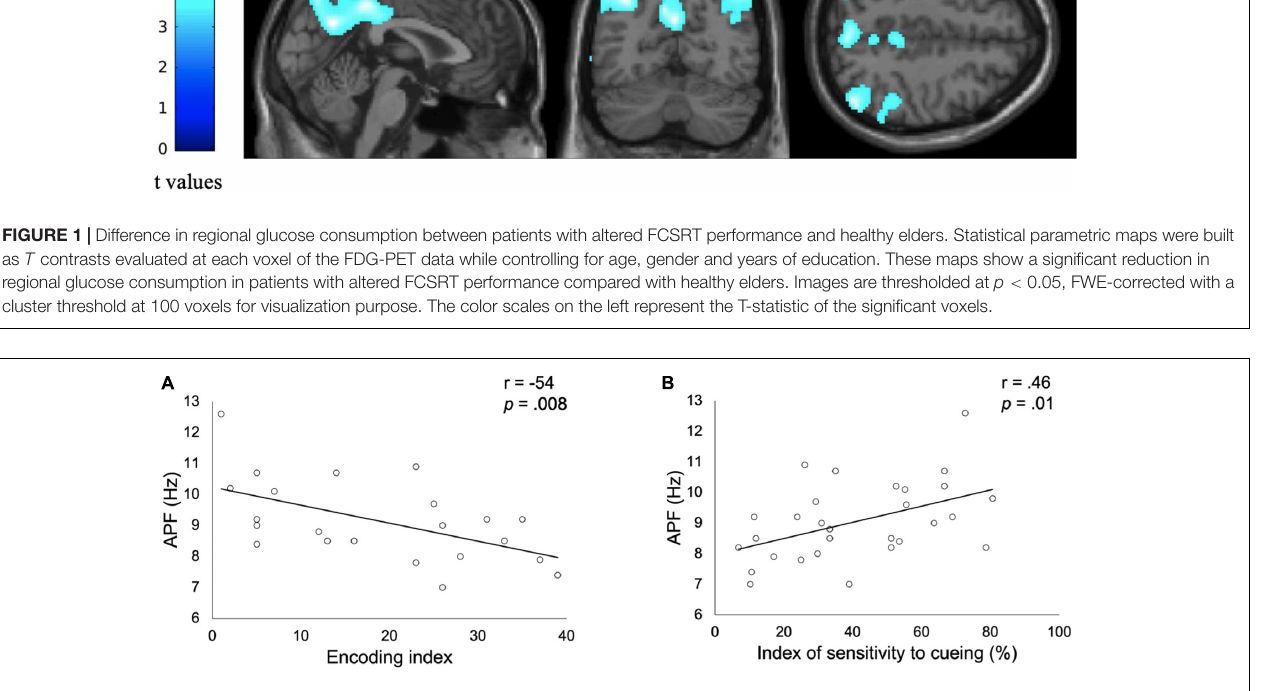
FIGURE 2 | Correlation between alpha peak frequency (APF) and the encoding impairment index (A) or the index of sensitivity to cueing (B) obtained in patients with altered FCSRT performance. Correlation coefficients r and p values (Bonferroni corrected for the two FCSRT indices considered) were estimated while controlling for age, gender and years of education.